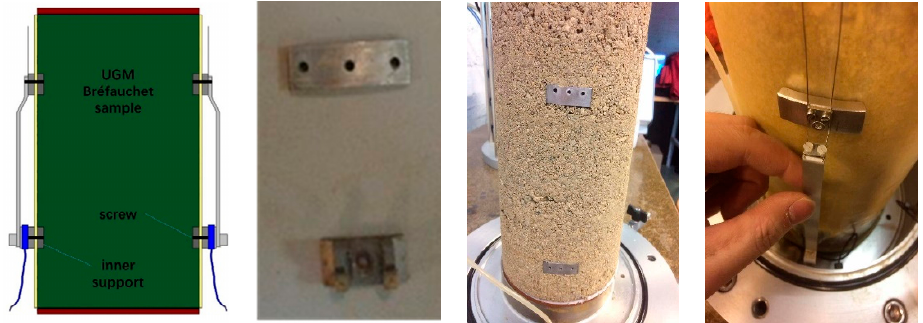
Figure 8. Fixing two vertical displacement transducers with screws.